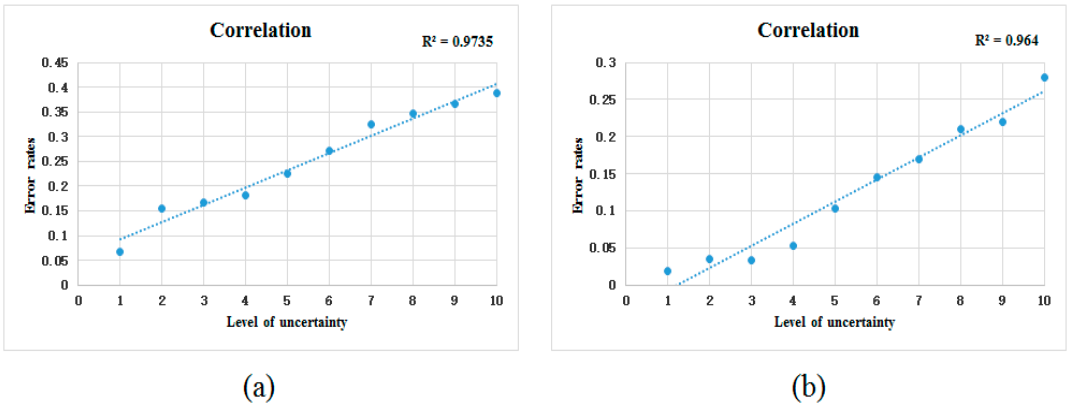
Figure 9. Scatterplots and fitted curves of the levels of uncertainty and classification error rates: ( a ) Vaihingen and ( b ) Potsdam images. (x-axis: levels of uncertainty, y-axis: classification error rates). Table 2. Fitted curve equations and correlation coefficients.